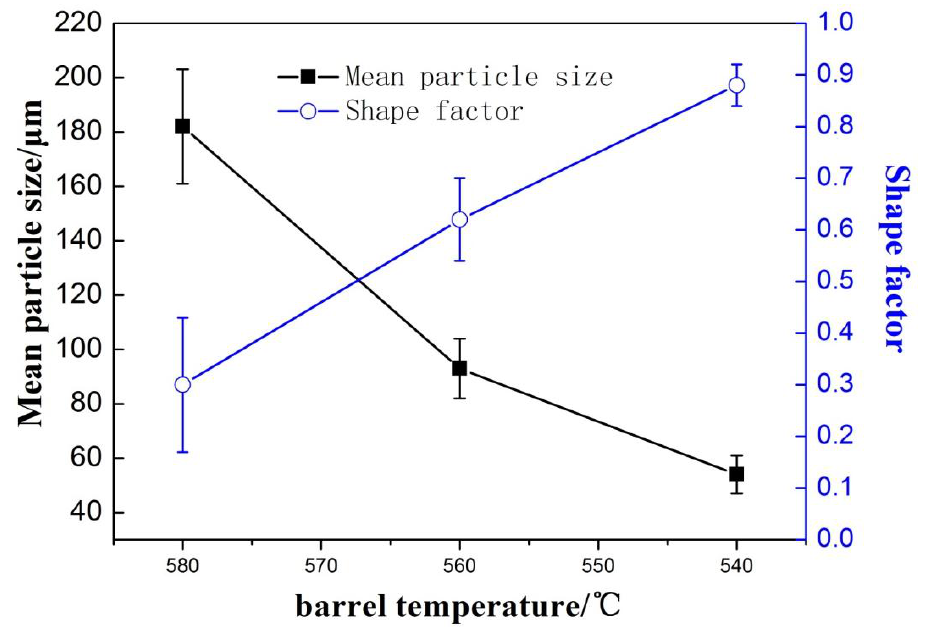
Figure 6. Variations of primary particle mean size and shape factor with barrel